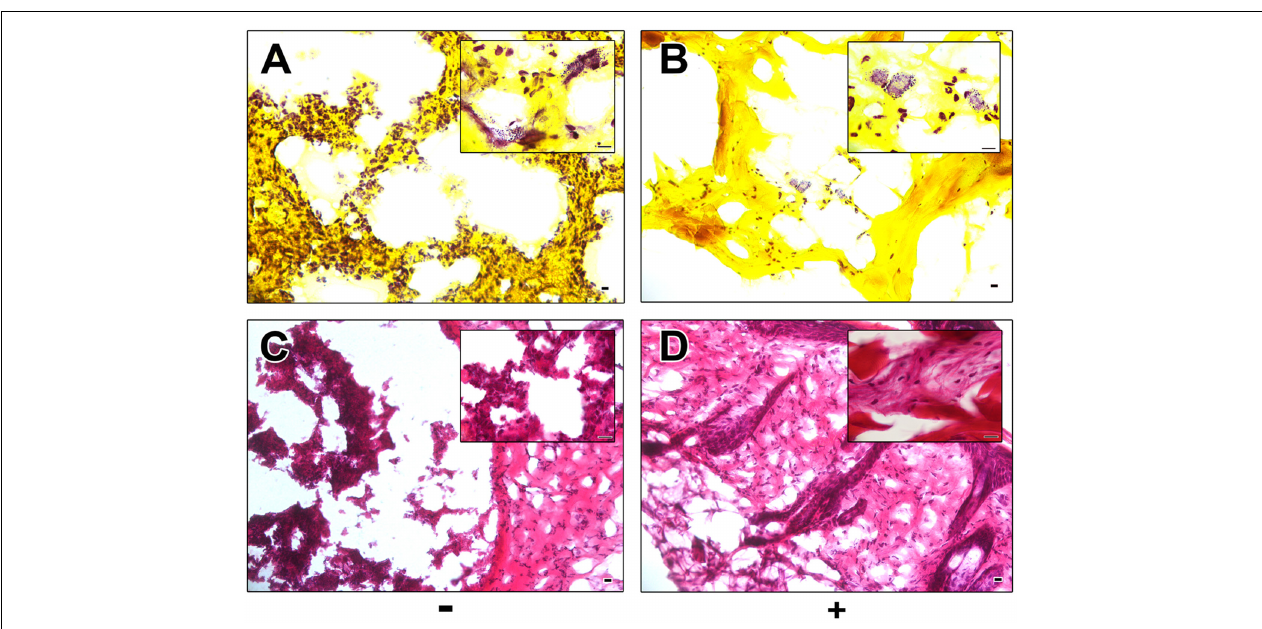
FIGURE 2 | Histological analysis of control and AP183 treated wounds. Gram (A,B) and H&E (C,D) stained sections of excised wounds infected with S. aureus Xen29 in the absence (A,C) and presence (B,D) of AP183 co-administration. Clusters of Gram-positive cocci were observed in higher frequency in untreated wounds than those treated with B. velezensis AP183. Scale indicates 100 µ